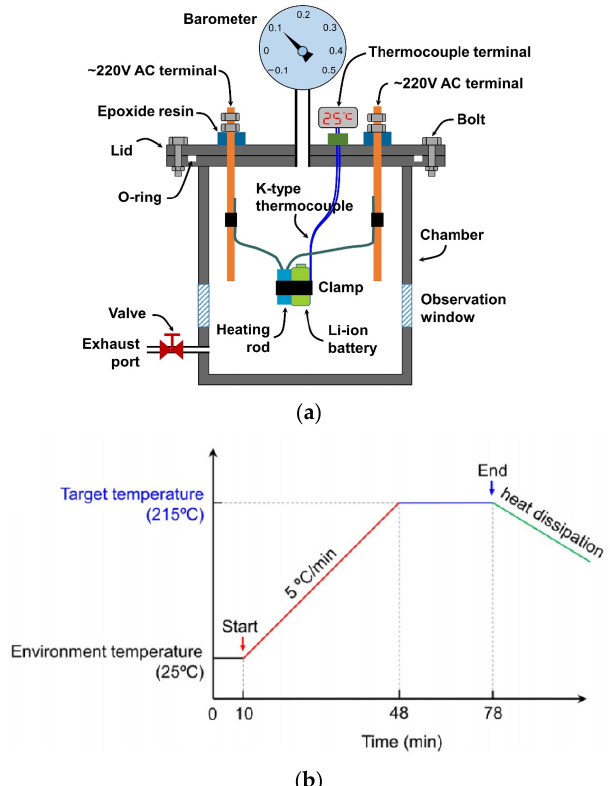
Figure 13. Thermal runaway experiment of NCM battery [84]. ( a ) Test container. ( b ) Load